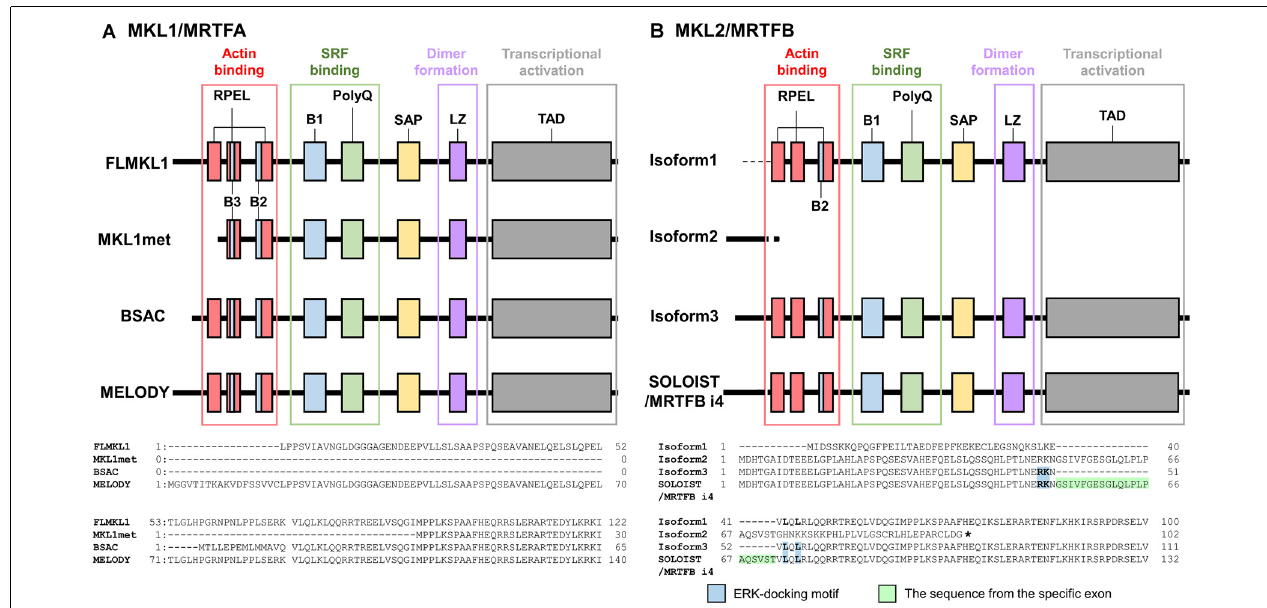
FIGURE 1 | Structures of MKL/MRTF isoforms. MKL/MRTF contains RPEL motifs, a basic region (B1, B2, or B3), polyglutamine repeat (polyQ), SAF-A/B, Acinus, PIAS domain (SAP), leucine zipper domain (LZ), and transcriptional activation domain (TAD). Domains and their functions were illustrated using the article Kalita et al. (2012) as a reference. (A) Structures of rat MKL1/MRTFA isoforms and variation of the N-termini of isoforms modified from Ishikawa et al. (2013). Full-length MKL1 has two translational start sites, giving rise to FLMKL1 with three RPEL motifs and MKL1met with two RPEL motifs. FLMKL1, BSAC, and MELODY have individual 5 (cid:48) exons and their N-terminal regions differ. (B) Structures of mouse MKL2/MRTFB isoforms and variation of the N-termini of isoforms modified from Ishibashi et al. (2020). Isoforms 1, 2, and 3 have individual 5 (cid:48) exons, isoform 3 and SOLOIST/MRTFB i4 have the same 5 (cid:48) exons. The difference between isoform 3 and SOLOIST/MRTFB i4 is a microexon encoding 21 amino acid residues, which disrupts the ERK-docking motif of isoform 3. SRF, serum response factor; MRTF, myocardin-related transcription factor; MKL, megakaryoblastic leukemia; BSAC, basic, SAP, and coiled-coil domain; MELODY, MKL1-elongated derivative of yield; FLMKL1, Full-length MKL1; SOLOIST, spliced neuronal long isoform of SRF transcriptional coactivator; RPEL, RPXXXEL; ERK, extracellular signal regulated